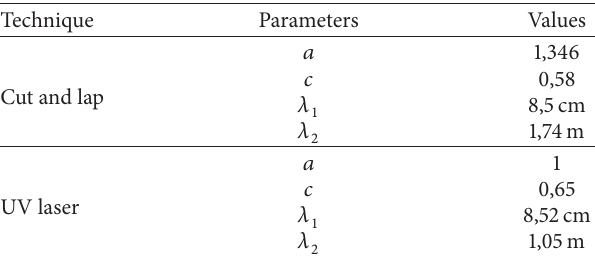
Figure 7: Schematic view and picture of the experimental setup. Table 2: Summary of the fit